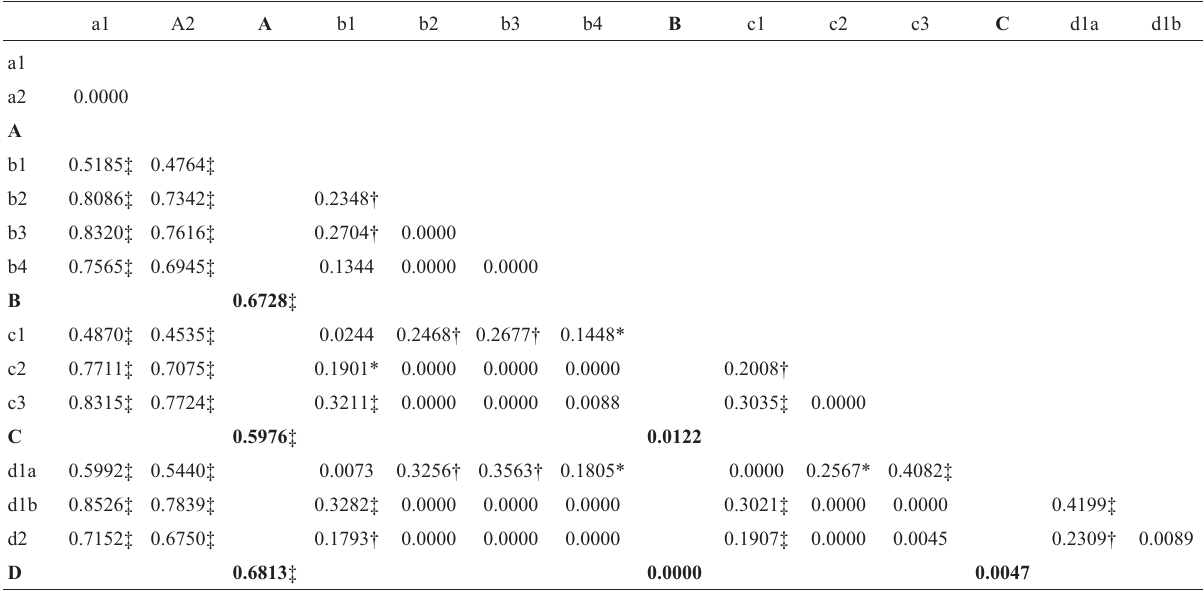
Table 3 - Pairwise F ST between populations and river systems (indicated in boldface) of C. striata , based on the COI gene . Significant F ST (p < 0.05, p < 0.01 and p < 0.001) based on 10000 permutations of haplotype frequencies among samples, after Bonferroni correction, are indicated with *, † and ‡, respectively.